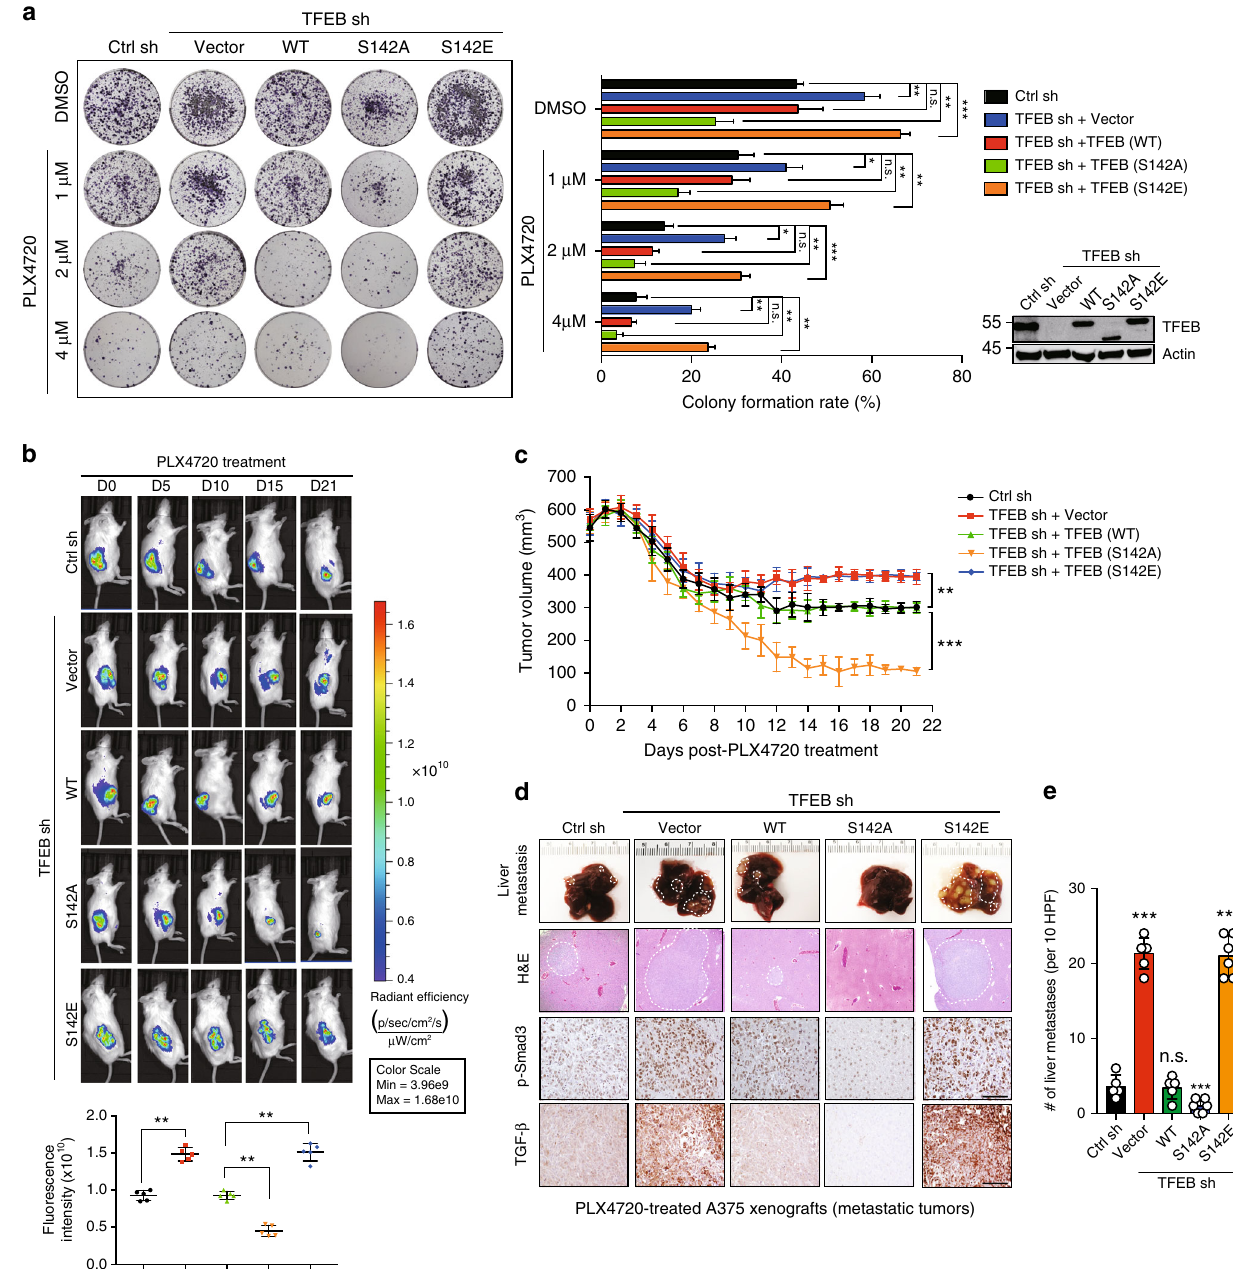
Fig. 8 TFEB S142 phosphorylation confers BRAFi resistance in melanoma cells. a Representative images (left) and quanti fi cation (right) of the colonogenic survival of A375 cells stably expressing control shRNA (pGIPZ) or TFEB shRNA complemented with empty vector, WT TFEB, and S142A or S142E TFEB mutants that are shRNA-resistant, after treatment with DMSO or PLX4720 at the indicated concentrations. Endogenous and reconstituted TFEB expression was con fi rmed by immunoblotting (bottom right). n = 3 independent experiments. b Bioluminescence images (top) of tumor regression of the indicated A375 R xenograft tumor genotype in live NOD/SCID mice at the indicated time after inoculation. Radiant ef fi ciency expressed as p/s/cm 2 /sr/ ( μ W/cm 2 ) was quanti fi ed (bottom). c Effect of PLX4720 on tumor response of xenografts formed by the indicated A375 cell lines. After tumor establishment (~ 500 mm 3 ), mice bearing A375 xenografts were treated with PLX4720 (20 mg/kg, i.p.) daily for 21 days. Values are the mean tumor volume ± SD per time point for 6 – 7 mice per group. d , e Representative gross images ( d ) of livers with metastatic nodules (top), H&E-stained sections (second row) and IHC analysis of TGF- β and p-Smad3 of the indicated A375 xenograft genotypes 21 days after PLX4720 treatment (20 mg/kg, i.p., daily). Scale bars, 100 μ m. The numbers of metastatic nodules in the liver in ( d ) was quanti fi ed in ( e ) ( n = 5 – 6 mice per group). For all quanti fi cation, data represent the mean ± SD derived from indicated number of independent experiments. Comparisons were made using Student ’ s t -test. * P < 0.05; ** P < 0.01; *** P < 0.001; n.s. not signi fi